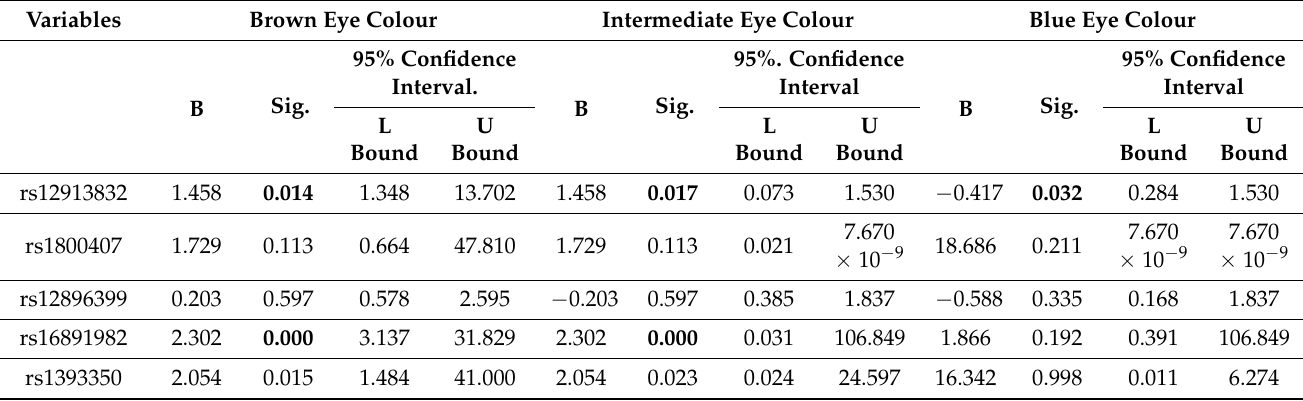
Table 4. Result of Multinomial logistic regression between SNPs and eye colour. The bold value indicated the significant with eye colour.